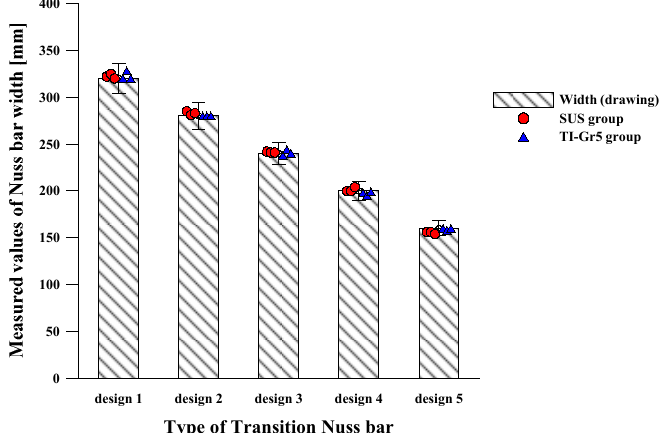
Figure 17. Results for the dimension accuracy of the central arc Nuss bar. This histogram shows the maximum height of the central arc Nuss bars (SUS and Ti-Gr5). Heights were measured and compared with original height.